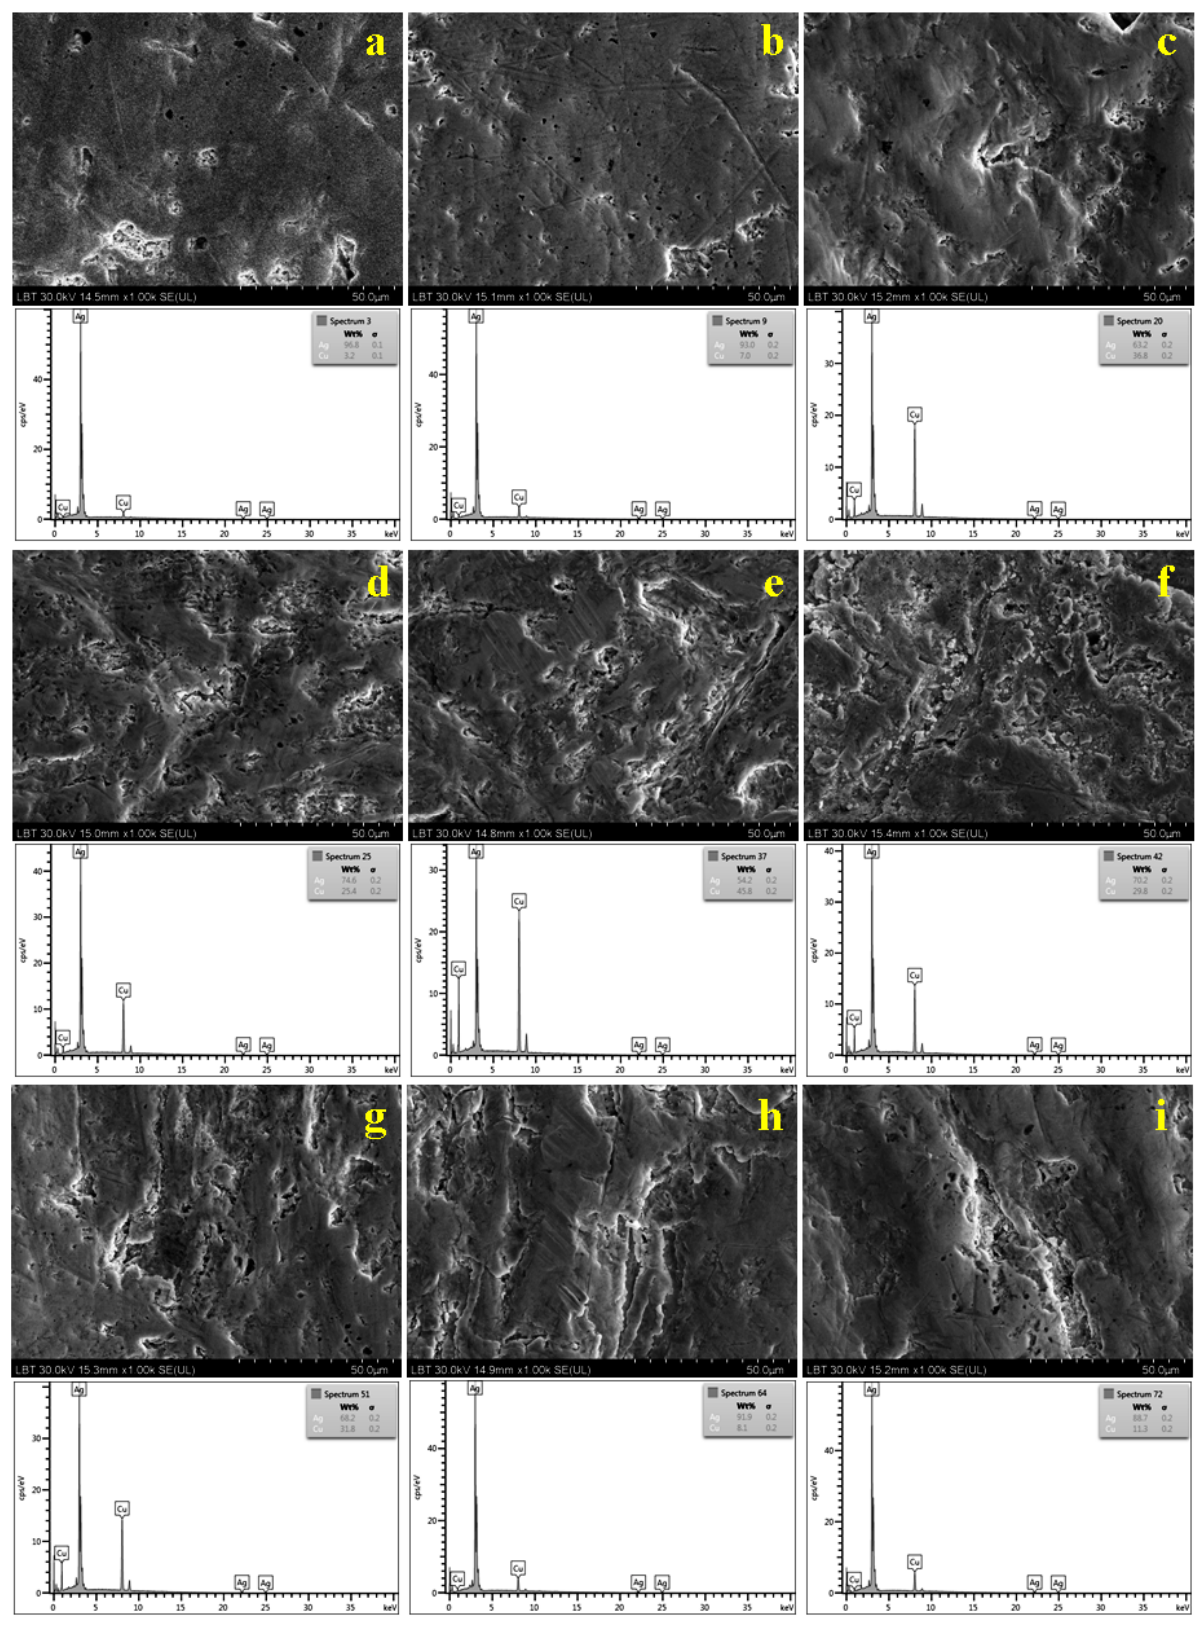
Figure 5. SEM images and EDS spectra resultingfrom the investigated 3-Polker coins issued in: ( a ) 1619, ( b ) 1620, ( c ) 1621, ( d ) 1622, ( e ) 1623, ( f ) 1624, ( g ) 1625, ( h ) 1626, and ( i ) 1627.